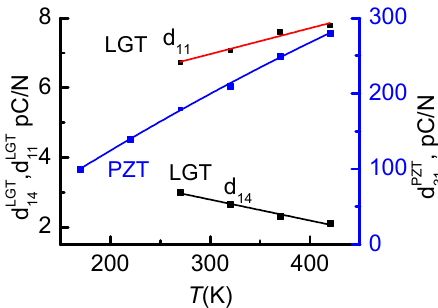
Figure 5. Temperature dependences of piezoelectric moduli for La 3 Ga 5.5 Ta 0.5 O 14 (LGT) and PZT materials [36–38].